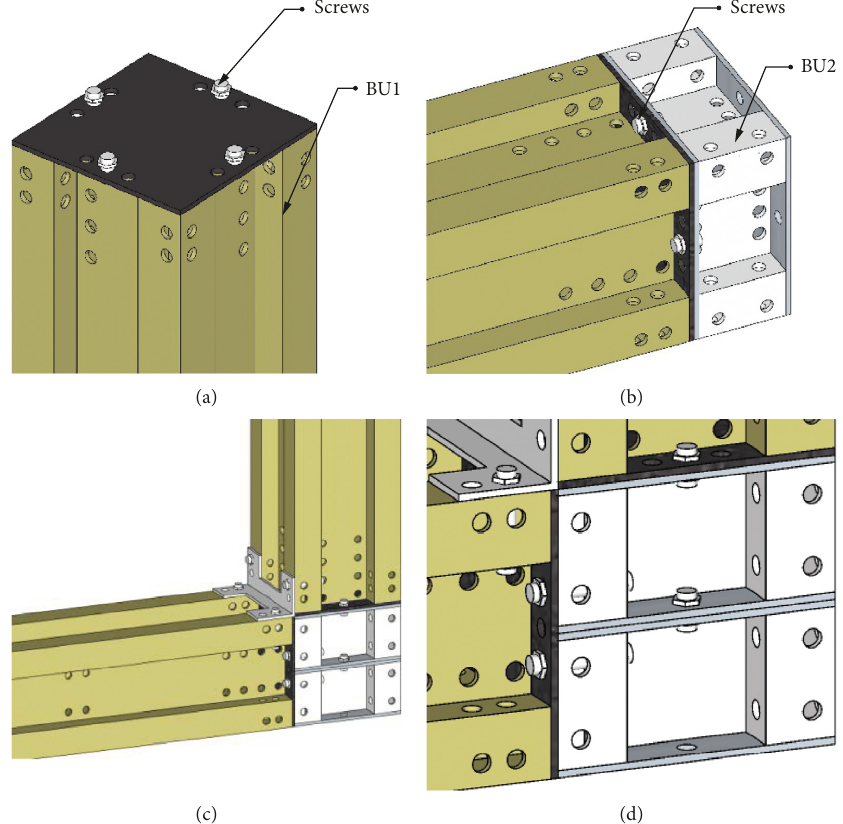
Figure 8: Connection of different basic units using mechanical fasteners. (a) Screws and BU1, (b) connection of BU1 and BU2, (c) orthogonal connection of BU1 and BU2 (2 units of BU2), and (d) detail of the orthogonal